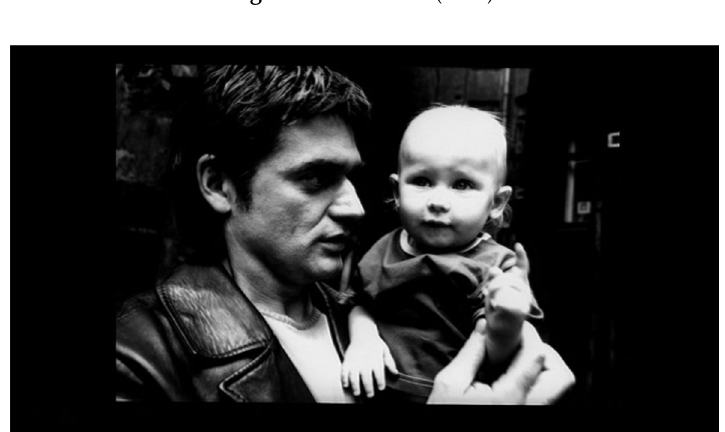
Figure 6. The Return (2003).